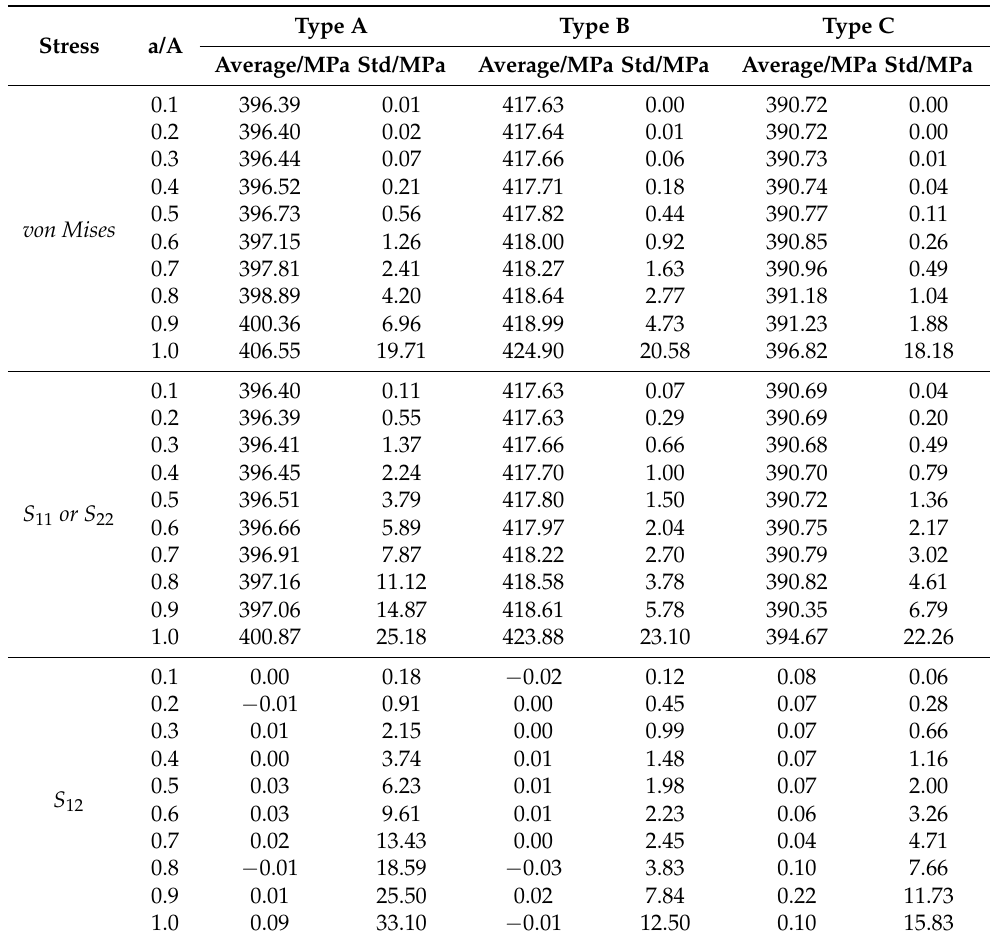
Table 1. The average and variance of stress in different regions.